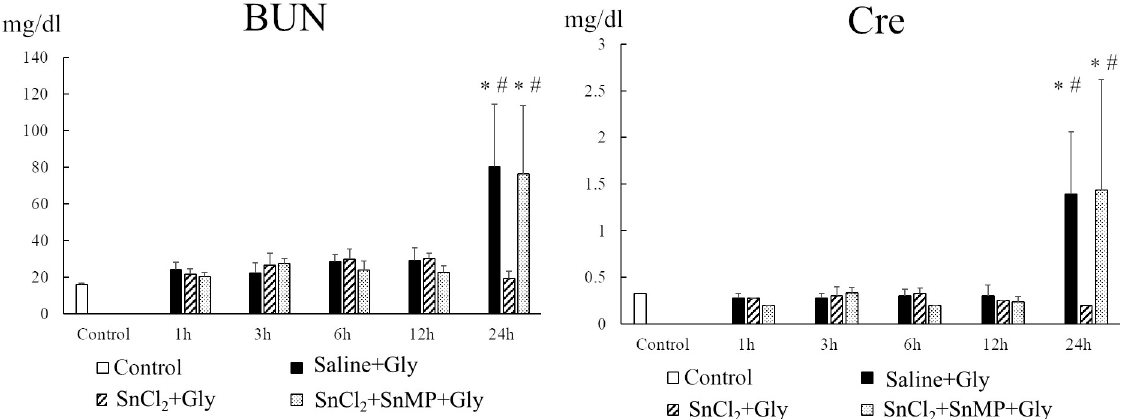
Fig 4. Effect of SnCl 2 pretreatment on changes in serum BUN and Cre levels after glycerol treatment. Rats pretreated with saline (s.c.) or SnCl 2 (s.c.) or SnCl 2 and SnMP (i.v.) 24 h before Gly treatment (10 mL/kg of 50% glycerol, i.m.) were sacrificed at 1, 3, 6, 12, and 24 h after Gly injection. Serum BUN and Cre levels were measured at each time after treatment. Control, untreated control rats; saline+Gly, saline- treated before Gly-treated rats; SnCl 2 +Gly, SnCl 2 -treated before Gly-treated rats; SnCl 2 +SnMP+Gly, SnCl 2 and SnMP-treated before Gly- treated rats. Data are expressed as the mean ± SD (n = 3–7). � p < 0.05 vs control group; # p < 0.05 vs SnCl 2 +Gly group. BUN, blood urea nitrogen; Cre, creatinine.